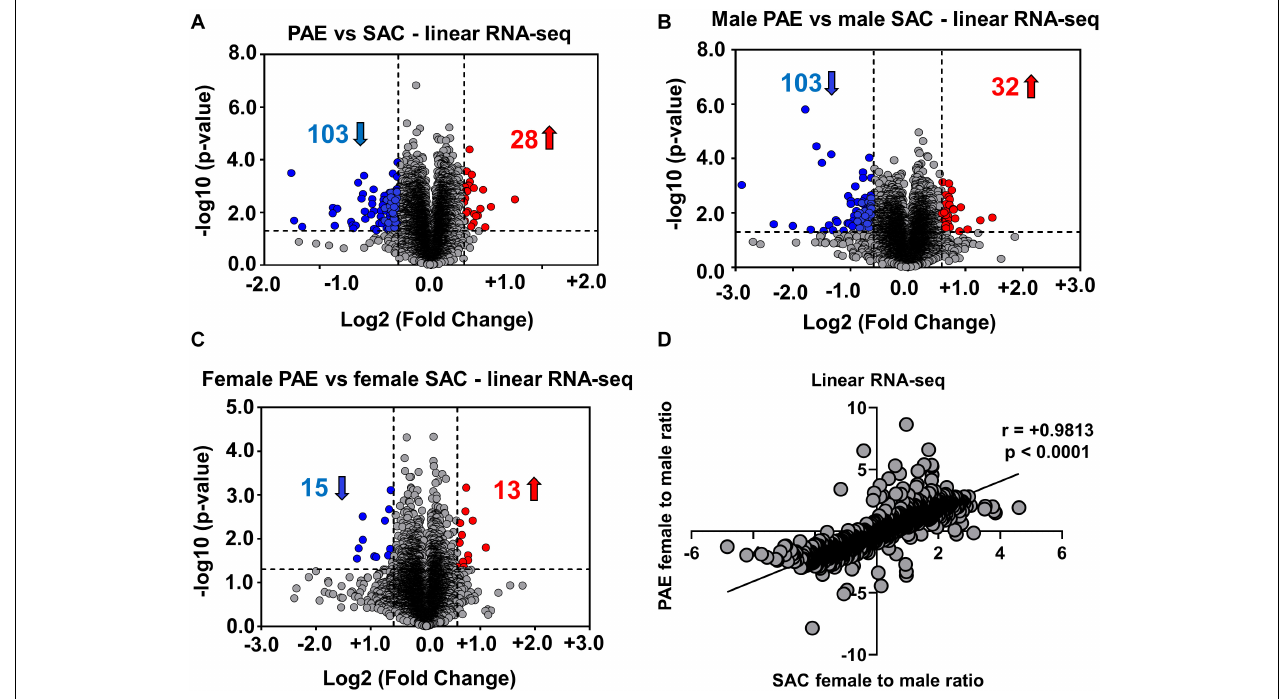
FIGURE 2 | Alterations in linear mRNA expression in embryonic brain following PAE. (A) Volcano plot showing overall fold changes in linear mRNAs in the same ( Figure 1B ) E18 whole brain samples. When expression in PAE was compared to SAC E18 whole brain, overall 28 linear mRNAs were upregulated and 103 linear mRNAs were downregulated (1.5-fold changes, p < 0.05). (B) Volcano plot showing a similar number of linear mRNAs being significantly altered when compared between male PAE and male SAC groups. 32 linear RNAs were upregulated and 103 linear RNAs were downregulated (1.5-fold changes, p < 0.05). (C) Volcano plot showing fewer linear mRNAs to be significantly altered when compared between female PAE and female SAC E18 whole brain. 13 linear mRNAs were upregulated and 15 linear mRNAs were downregulated with 1.5-fold changes ( p < 0.05). In all volcano plots (A–C) , X -axis represents log2 fold change (dotted line = 1.5-fold), Y -axis represents –log10 p -value (dotted line: p = 0.05). (D) A robust positive correlation (Spearman correlation coefficient r = 0.9813, two-tailed p -value p < 0.0001) between female to male ratios in SAC and PAE mice was observed in linear